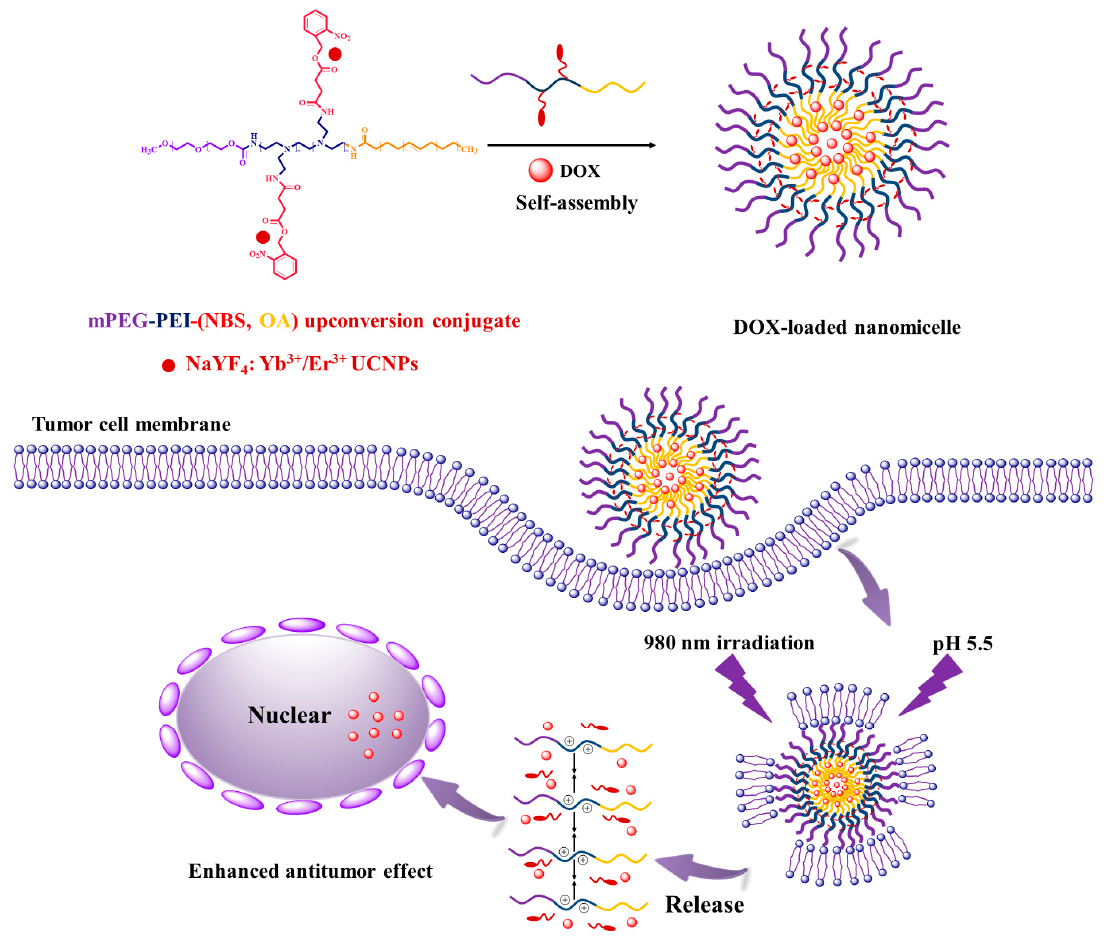
Figure 1. Scheme of doxorubicin (DOX)-loaded oleic acid (OA) copolymer upconversion nanomicelles penetrating the cell membranes and delivering DOX into tumor cells.